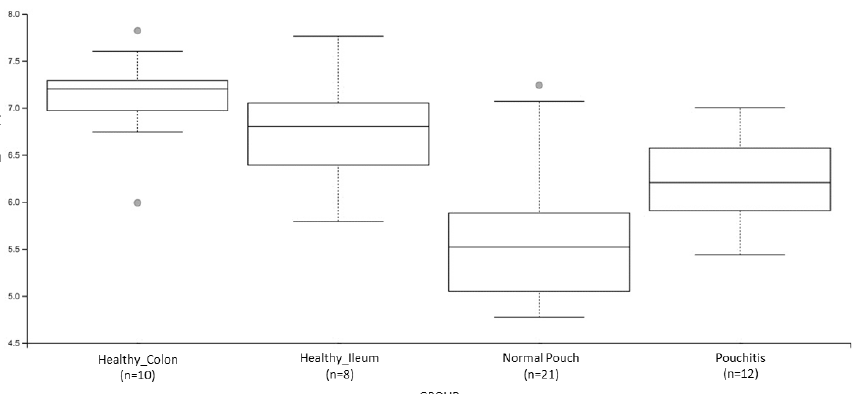
Figure 2. Boxplot for group-specific Shannon’s entropy distributions. See Table 2 and Supplemen-